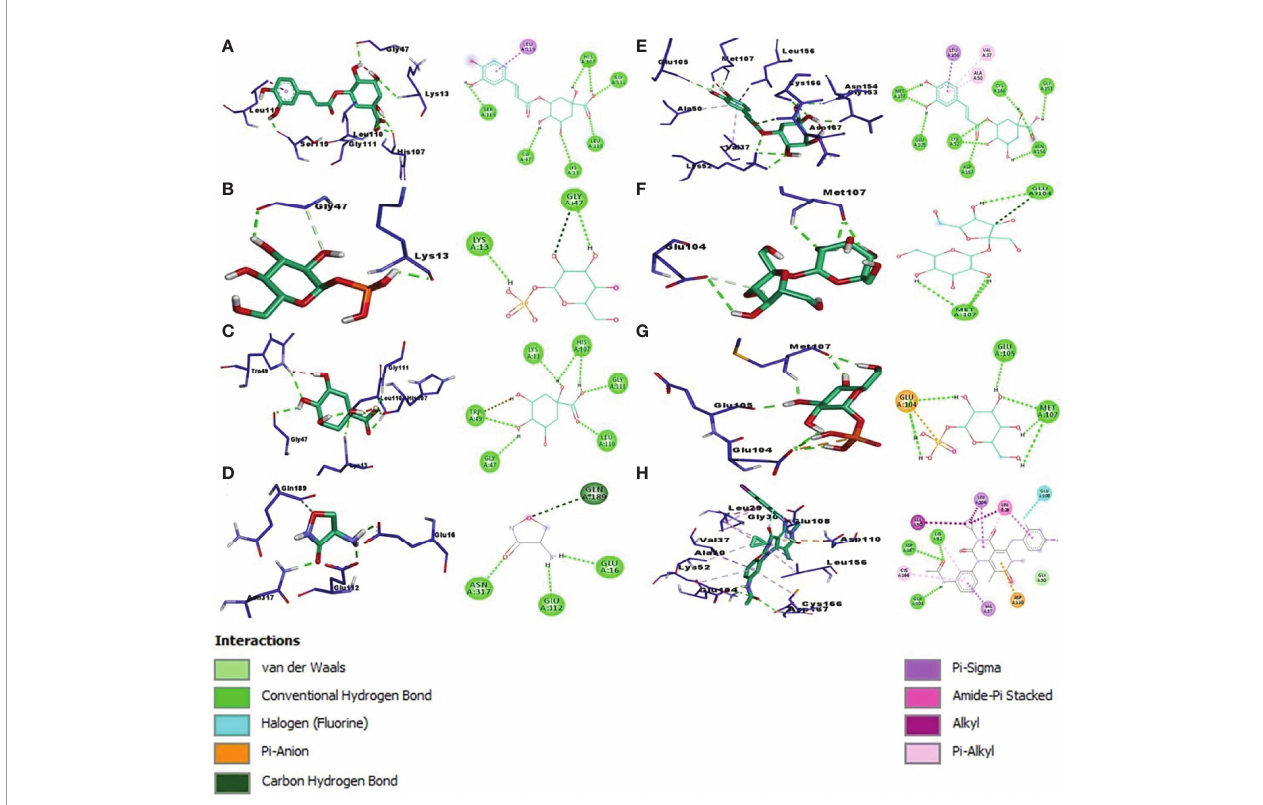
FIGURE 4 | Left panel of each alphabet showing 3D image while right panel indicating the 2D image. Molecular docking interaction and different bond formation of quinic acid, 3-caffeoyl (A) , glucose-1-phosphate (B) , quinic acid (C) , and Dcycloserine (D) with DdlA protein of Xoo. Molecular docking interaction of quinic acid 3 caffeoyl (E) , sucrose (F) , glucose-1-phosphate (G) , and Trametinib (H) with MAPK1 protein of M